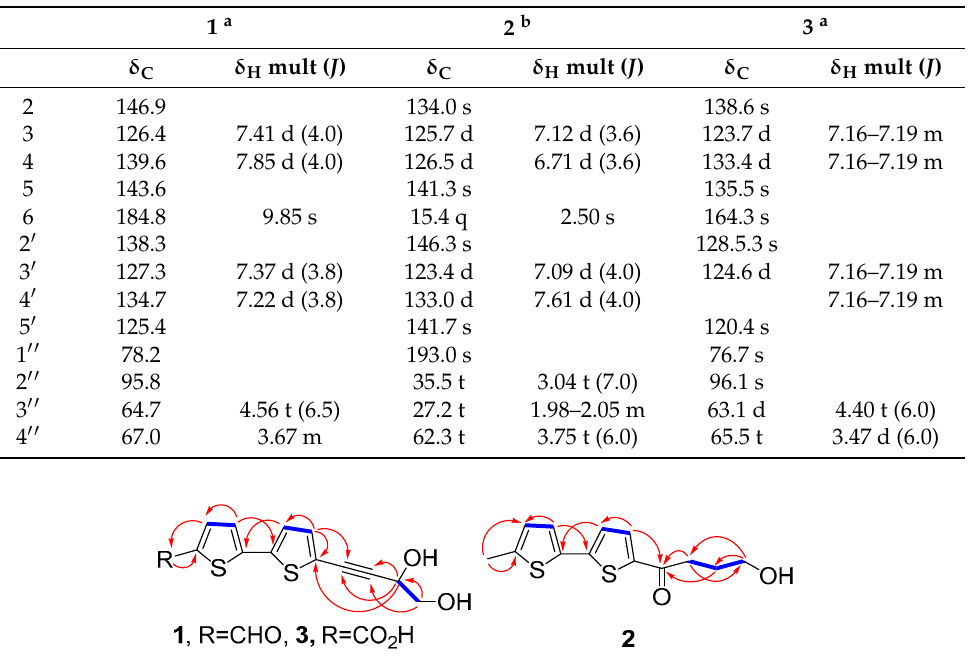
recorded in CDCl 3 ) ( δ in ppm, J in Hz).